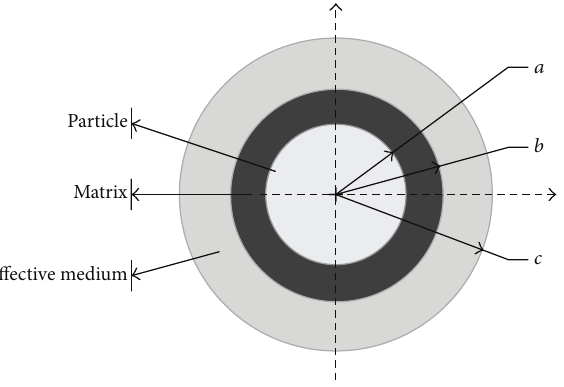
Figure 2: Three-Phase Sphere model.